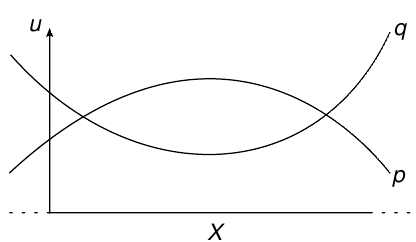
Figure 1 . Points p and q in spacetime can be visualised as curves in minitwistor space, where the coordinate u is defined at each point on the Riemann spheres X p and X q corresponding to p and q . Curves associated with different spacetime points can intersect in at least two